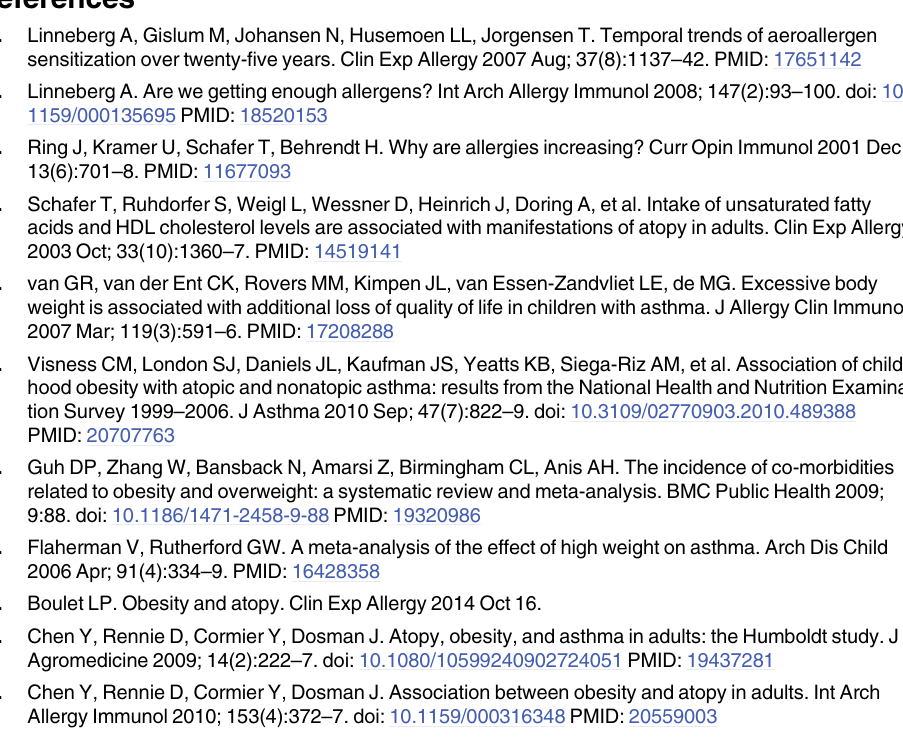
S9 Fig. Random effects meta-analyses of the study-specific associations between serum total cholesterol and atopy. Abbreviations: a98, Allergy98; h06, Health2006; h08, Health2008; h10, Health2010; i99, Inter99; k36, 1936-cohort; m1, Monica1; OR, odds ratio; CI, confidence interval. S10 Fig. Random effects meta-analyses of the study-specific associations between body mass index and atopy. Abbreviations: a98, Allergy98; h06, Health2006; h08, Health2008; h10, Health2010; i99, Inter99; k36, 1936-cohort; m1, Monica1; OR, odds ratio; CI, confidence inter- val. S1 Table. Description of the included studies. Study participants were drawn as a random samples of the general population living in a defined area of the Western part of Copenhagen. S2 Table. Characteristics of the study populations (persons with no missing values, N =